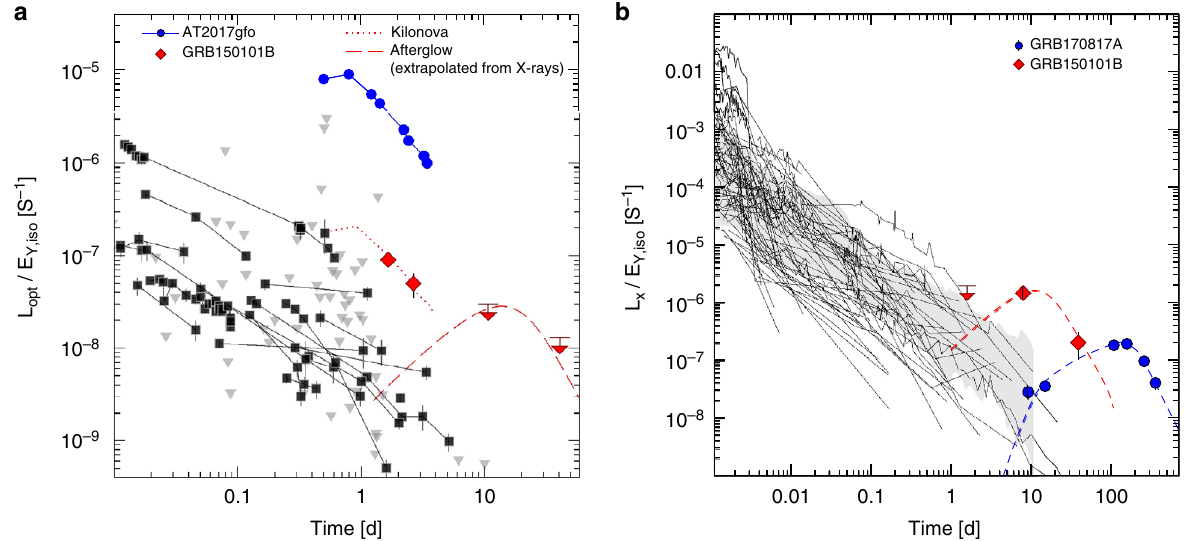
Fig. 2 Comparison of GRB150101B with GW and GRB afterglows. a Optical light curves of short GRBs normalized to the observed gamma-ray energy release. Downward triangles are 3 σ upper limits. Vertical error bars are 1 σ . The optical afterglow of GRB170817A became visible >100 days after the merger 21 and is not reported in the plot. b X-ray light curves of short GRBs normalized to the observed gamma-ray energy release. The shaded area shows the 68% dispersion region. In both cases, the counterparts of GW170817 (AT2017gfo and GRB170817A) and GRB150101B stand out of the sample of standard afterglows. They can be described as a bright kilonova (dotted lines) followed by a late-peaking off-axis afterglow (dashed